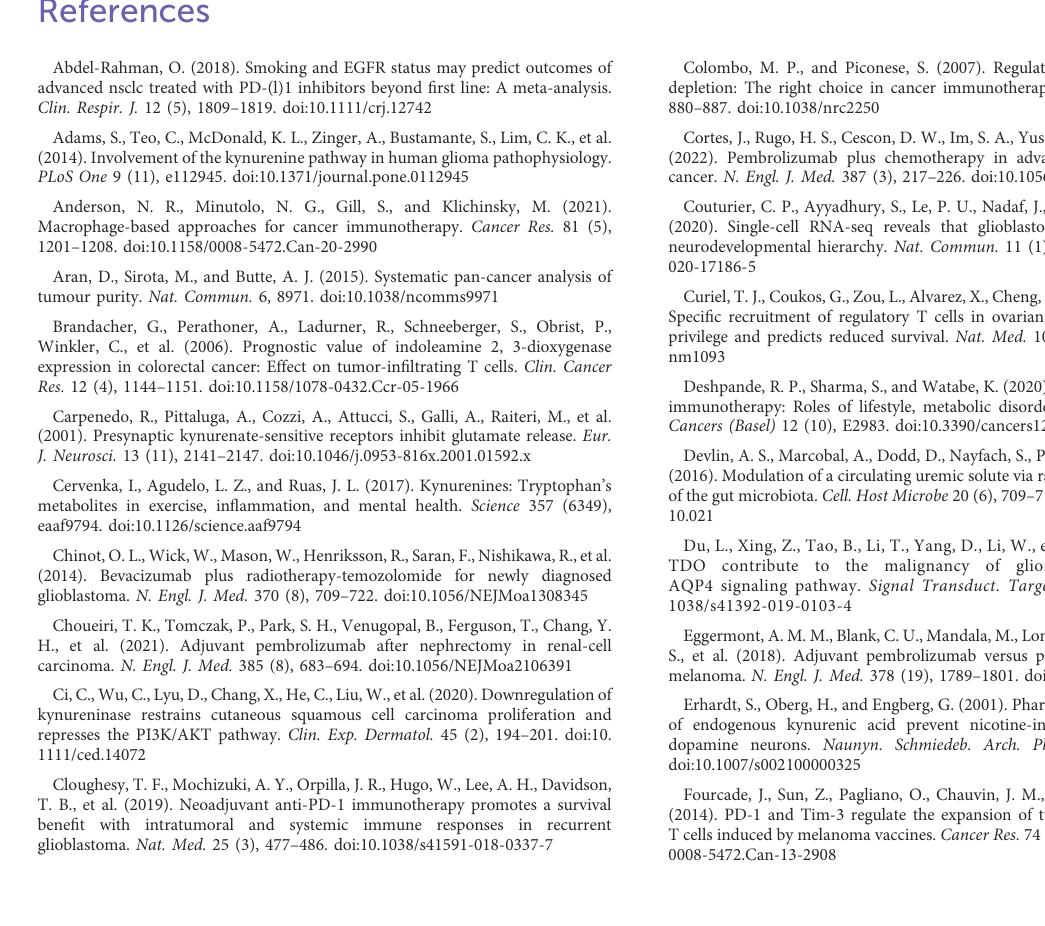
SUPPLEMENTARY FIGURE S1 (A) Average silhouette width corresponding to each cluster number (k) in K-means clustering of the gliomas based on TrMG expression. (B) Heatmap of expression of 44 TrMGs based on two clusters. (C) Differences in the expression of 44 TrMGs between two K-means clusters. * p < 0.05; ** p < 0.01; *** p < 0.001; **** p < 0.0001. SUPPLEMENTARY FIGURE S2 Differences in the clinicopathological features between two K-means clusters. * p < 0.05; ** p < 0.01; *** p < 0.001; **** p < 0.0001. SUPPLEMENTARY FIGURE S3 Representative immunohistochemical staining for KYNU and ALDH2 from the Human Protein Atlas. (A) Representative staining for KYNU in high- and low-grade glioma (https://www.proteinatlas.org/ ENSG00000115919-KYNU/, antibody: HPA031686). (B) Representative staining for ALDH2 in high- and low-grade glioma (https://www. proteinatlas.org/ENSG00000111275-ALDH2/, antibody: HPA051065). SUPPLEMENTARY FIGURE S4 Differences in immunological characteristics of tumor microenvironment between two TrMRS risk groups in CGGA, REMBRANDT, and WCH cohorts. * p < 0.05; ** p < 0.01; *** p < 0.001; **** p <